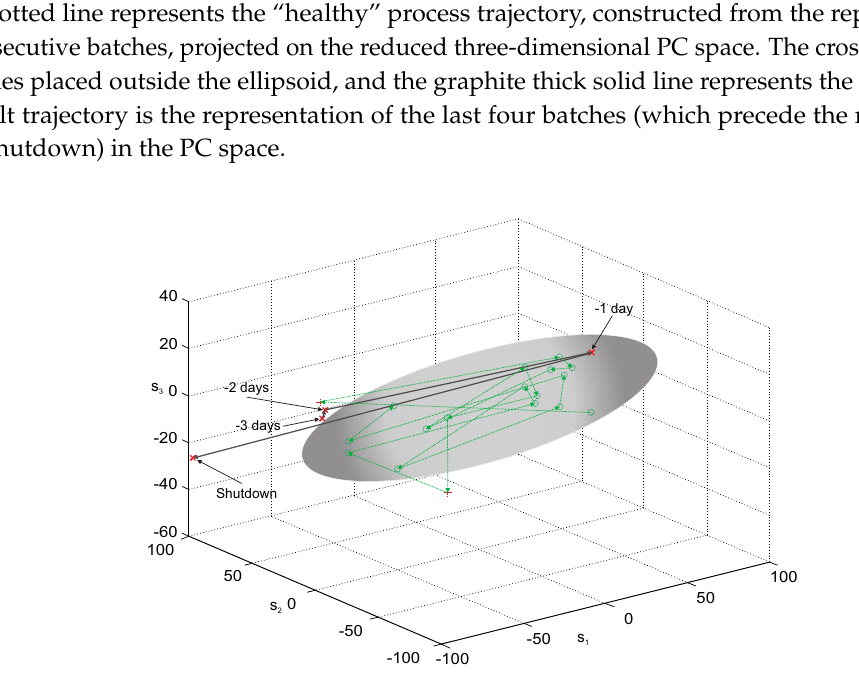
Figure 10. Fault trajectory for leakage location—pipes damaged on 13th January